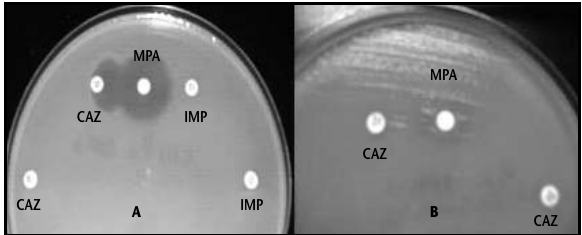
Figura 2 – Ilustração de resultados de teste fenotípico para detecção de MBL com amostra de P. aeruginosa (método de disco